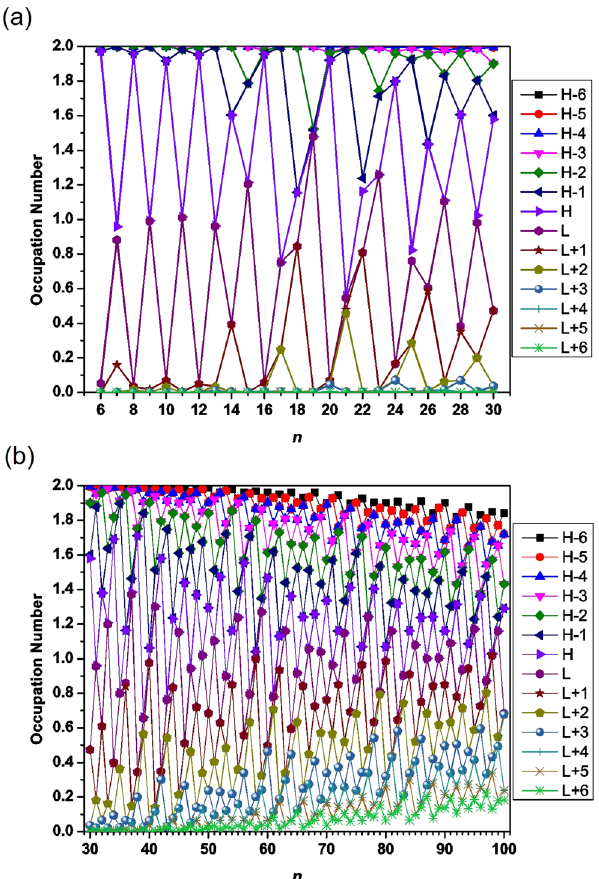
Figure 6. Occupation numbers of active orbitals for the ground state of c -BNR[2, n ] (( a ) n = 6–30 and ( b ) n = 30–100), obtained from spin-restricted TAO-LDA. Here, for simplicity, HOMO and LUMO are referred to as H and L,